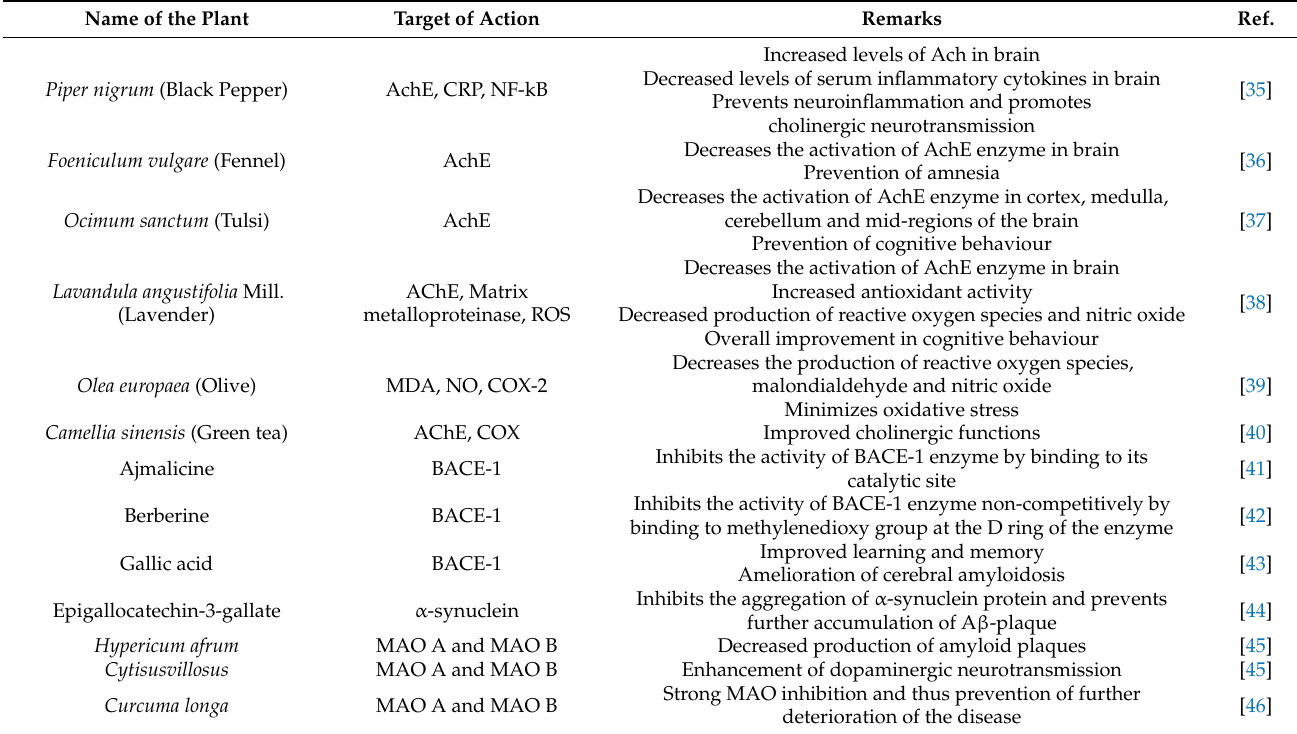
Table 1. Herbal drugs along with their mechanisms in the management of Alzheimer’s